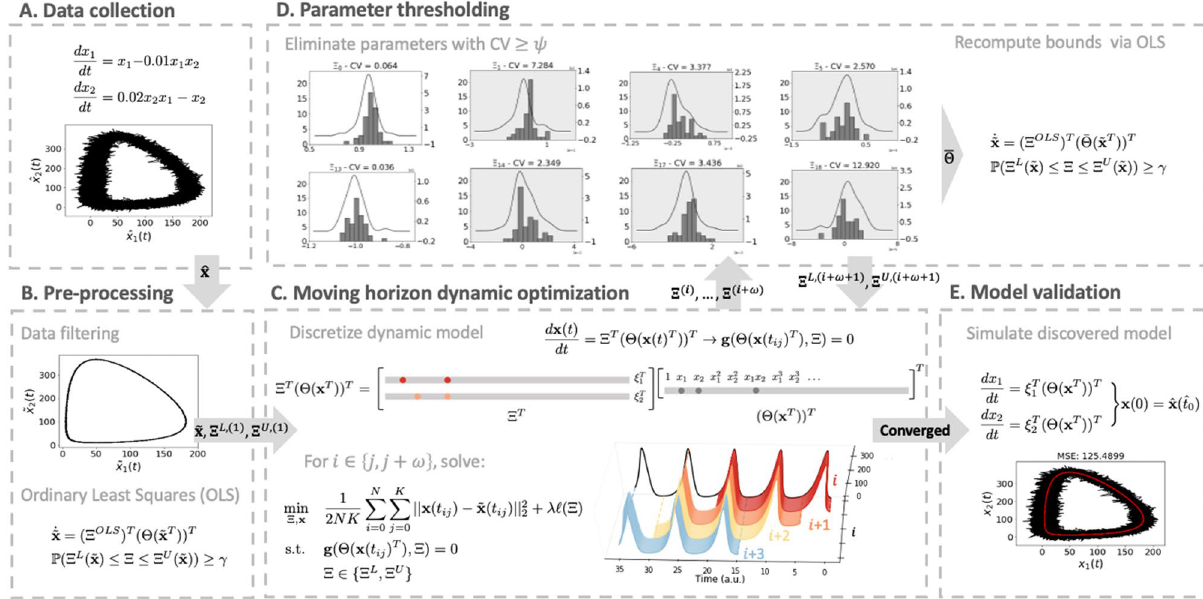
Figure 1. Summary of the present framework using the Lotka–Volterra system as an illustrative example, and T , c ) for simplicity without considering control inputs u or parametric basis functions �( x . ( A ) Noisy data ˆ x are collected from physical experimentation or simulation. ( B ) The data are smoothed using filtering techniques and preliminary statistical analyses are performed to refine the library of basis functions and initialize the DNLP. ( C ) The dynamics are discretized and the DNLP is solved for the current window of data. ( D ) Every ω iterations of the moving horizon algorithm, coefficient thresholding is performed to eliminate basis functions having a coefficient of variation greater than a given tolerance (exemplified by histograms with grey background). ( E ) Once convergence is established the recovered equations are validated via simulation, by subsequently computing suitable regression error metrics, and by applying visualization